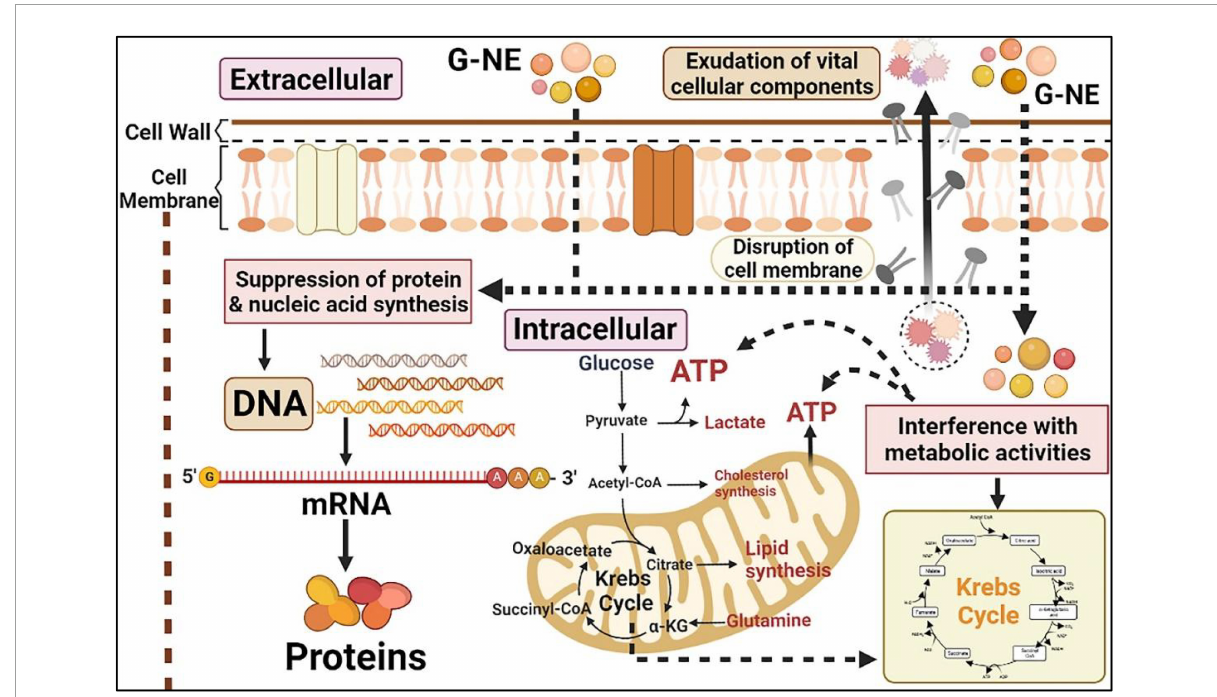
FIGURE11 Effects of G-NE on bacteria (The figure was created employing online software named